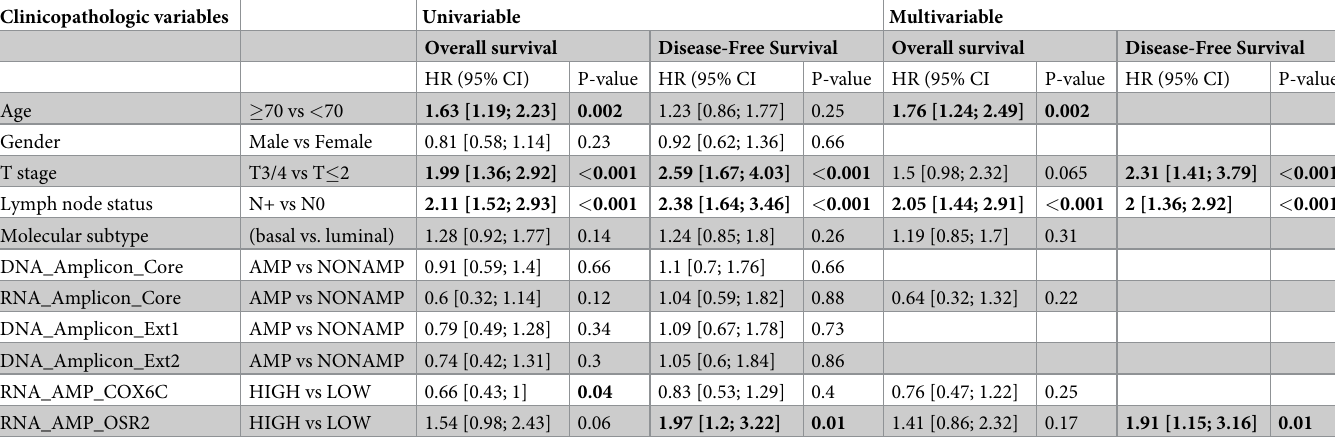
Univariable and multivariable analysis of Overall survival (OS) and Disease-Free Survival (DFS), including clinicopathologic characteristics, amplicon definitions, and gene definitions. Variables from univariable analysis with a p-value of < 0.2 were entered into a multivariable model. P-values with a statistical significance of < 0.05 are highlighted in bold .